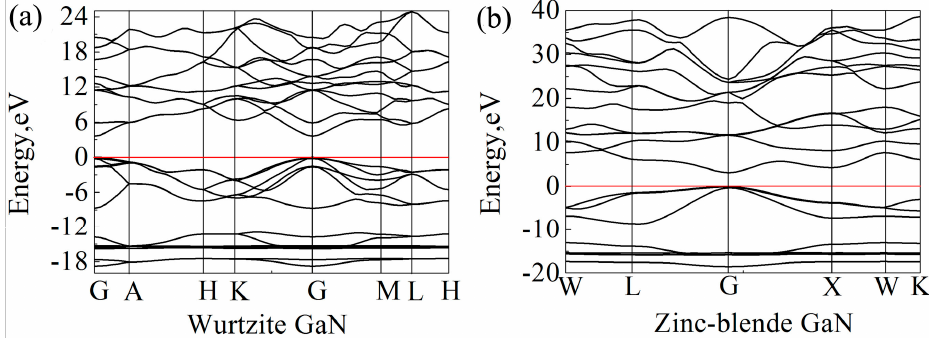
Figure 6. Band structures of GaN crystals: ( a ) Wurtzite GaN; and ( b ) zinc-blende GaN. The Fermi level is set to zero (see the red line).